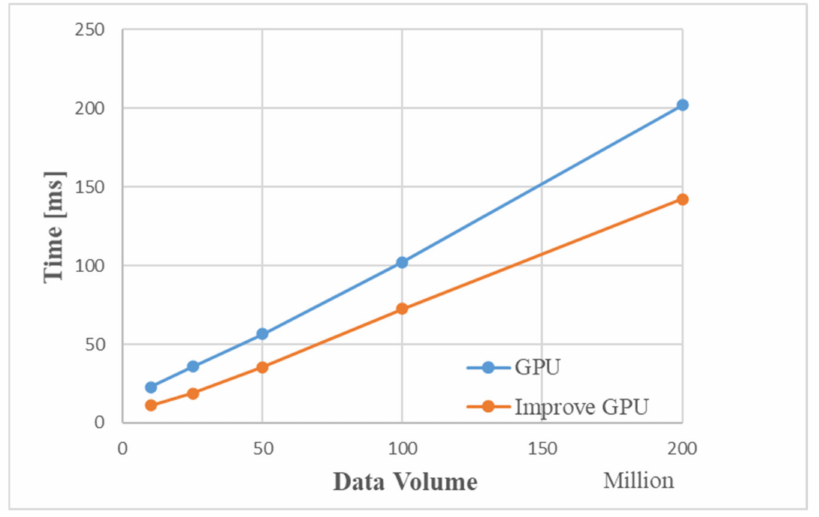
Figure 19. Comparison of the time taken by the GPU with the improved algorithm and the tradi- tional